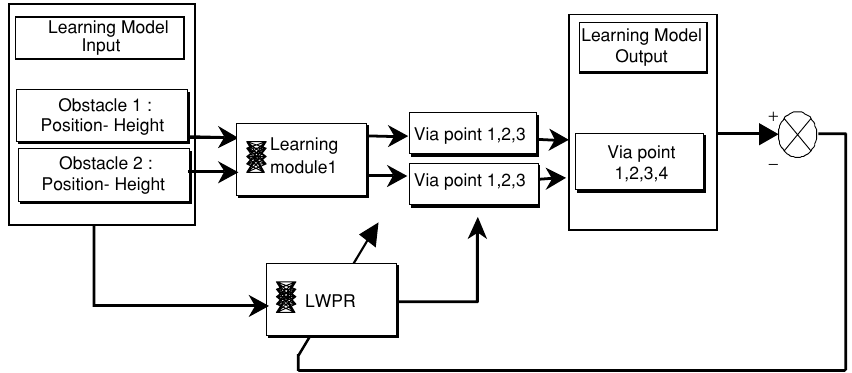
Figure 14 Algorithm for the via point position learning.